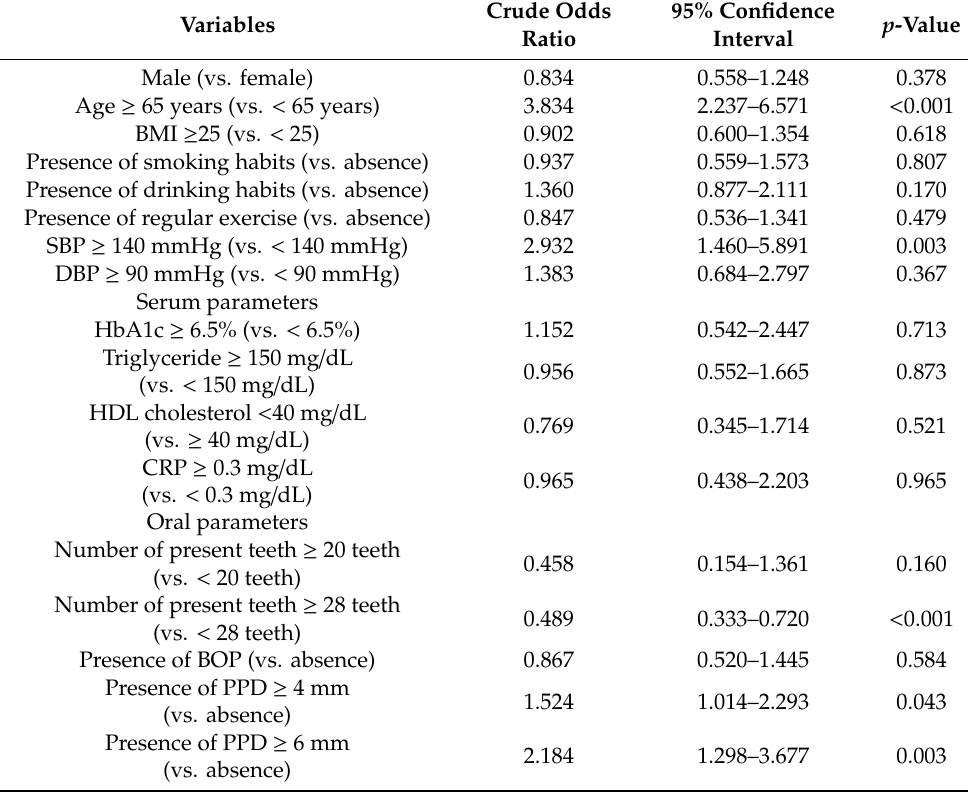
Table 4. Factors associated with DSWMH lesions: univariate logistic regression